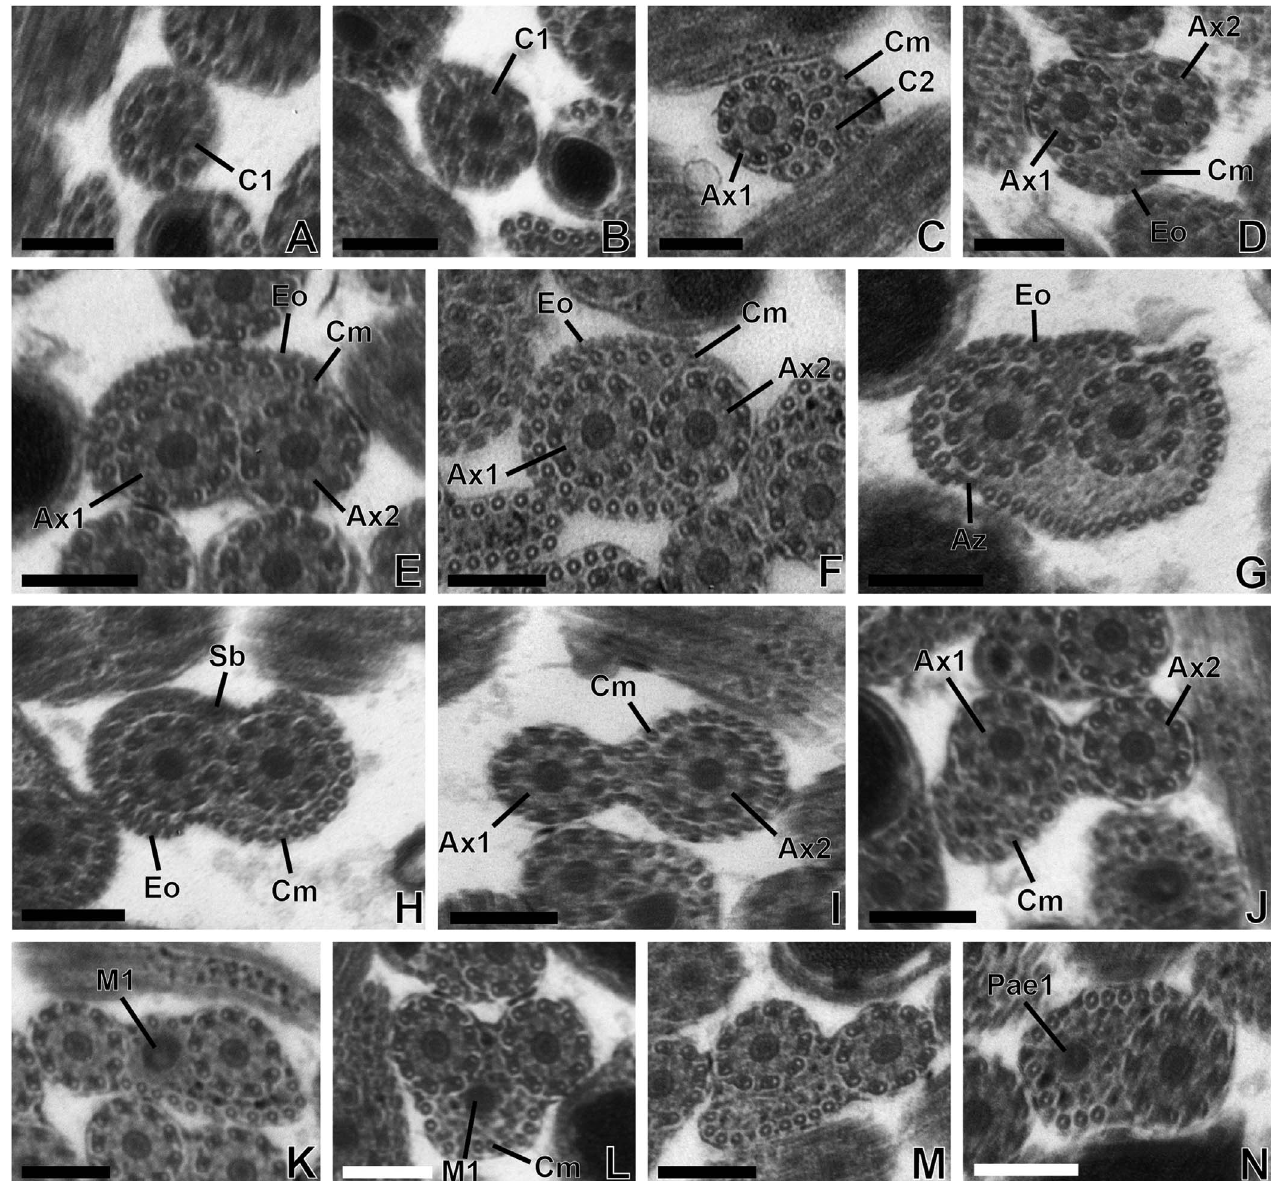
Figure 1. (A – N) Transmission electron micrographs of regions I, II and III of the mature spermatozoon of Tergestia clonacantha. Scale bars = 0.2 l m. (A – C) Cross-sections in the anterior extremity (or region I) of the spermatozoon. (A – B) Cross-sections in the anterior extremity of the spermatozoon with only the centriole (C1) of axoneme 1 (A (cid:1) 1), cortical microtubules (Cm) and the centriole of axoneme 2 (C2). (C) Cross- section in the anterior extremity of the spermatozoon with axoneme 1, fi ve cortical microtubules, and the centriole of axoneme 2 (C2). (D – H) Cross-sections in region II of the spermatozoon . (D) Cross-section in region II of the spermatozoon with the two axonemes (A (cid:1) 1 and A (cid:1) 2), cortical microtubules (Cm), and the external ornamentation of the plasma membrane (Eo). (D – H) Cross-sections in region II of the mature spermatozoon showing the two axonemes, an increasing number of cortical microtubules up to 36 in (G), and the external ornamentation of the plasma membrane and spine-like body (H). (I – N) Cross-sections in region III of the spermatozoon. (I) Cross-sections in region III of the mature spermatozoon showing only the two axonemes, a row of 23 cortical microtubules next to axoneme 2, a decrease of cortical microtubules up to 12 (J), the appearance of the fi rst mitochondrion (M1) (K), a progressive decrease of cortical microtubules (L – M) and the disorganization of axoneme 1 (Pae1)